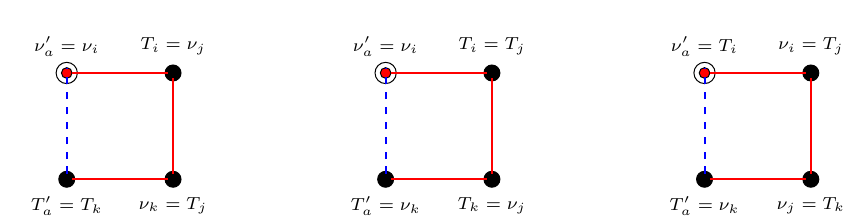
Figure 7.5: Cycles of length 4 including the verification query which is denoted by the concentric circle